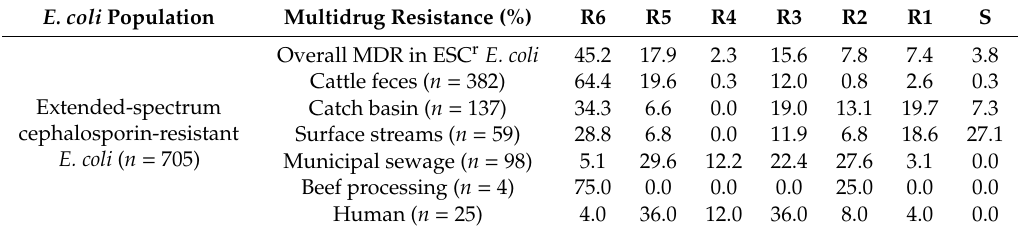
Table 2. Distribution of multidrug resistance in extended-spectrum cephalosporin-resistant E. coli and generic E. coli population per